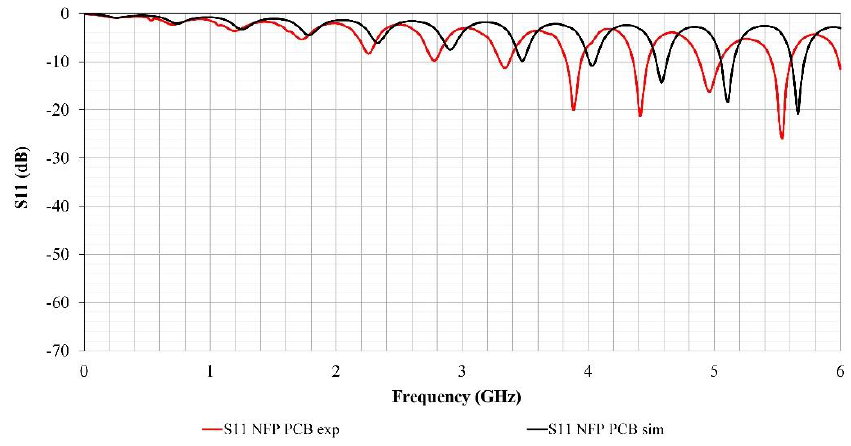
Figure 9. Comparison of the NFP-PCB S 11 parameter obtained by FEM simulation and experimentally measured.